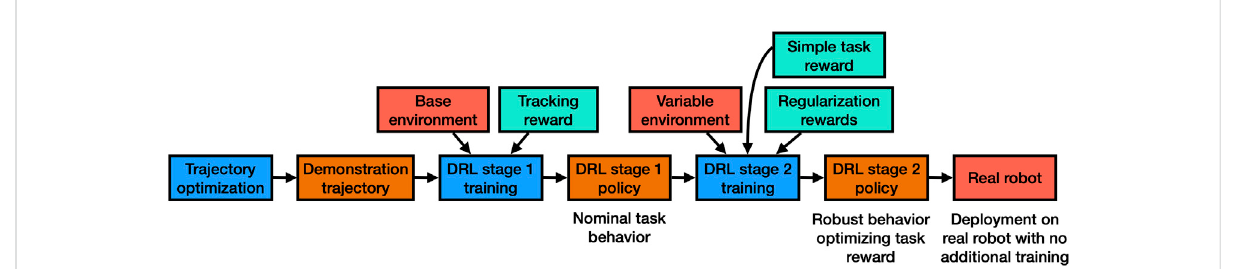
FIGURE 1 Schematicofourproposedframework.WestartfromasingledemonstrationtrajectorygeneratedbyTO.Inthe fi rstDRLstagewelearnapolicy that tracks that demonstration trajectory and successfully produces nominal behavior in simulation. To enable transfer to the real robot, the second DRLstagestartswiththeresultingpolicyfromthe fi rststageandtriestorobustifythepolicybyrandomizingcontactandtooptimizeforperformance by replacing demonstration tracking reward with task reward. We directly apply the output policy from the second stage to the robot without any domain randomization of robot